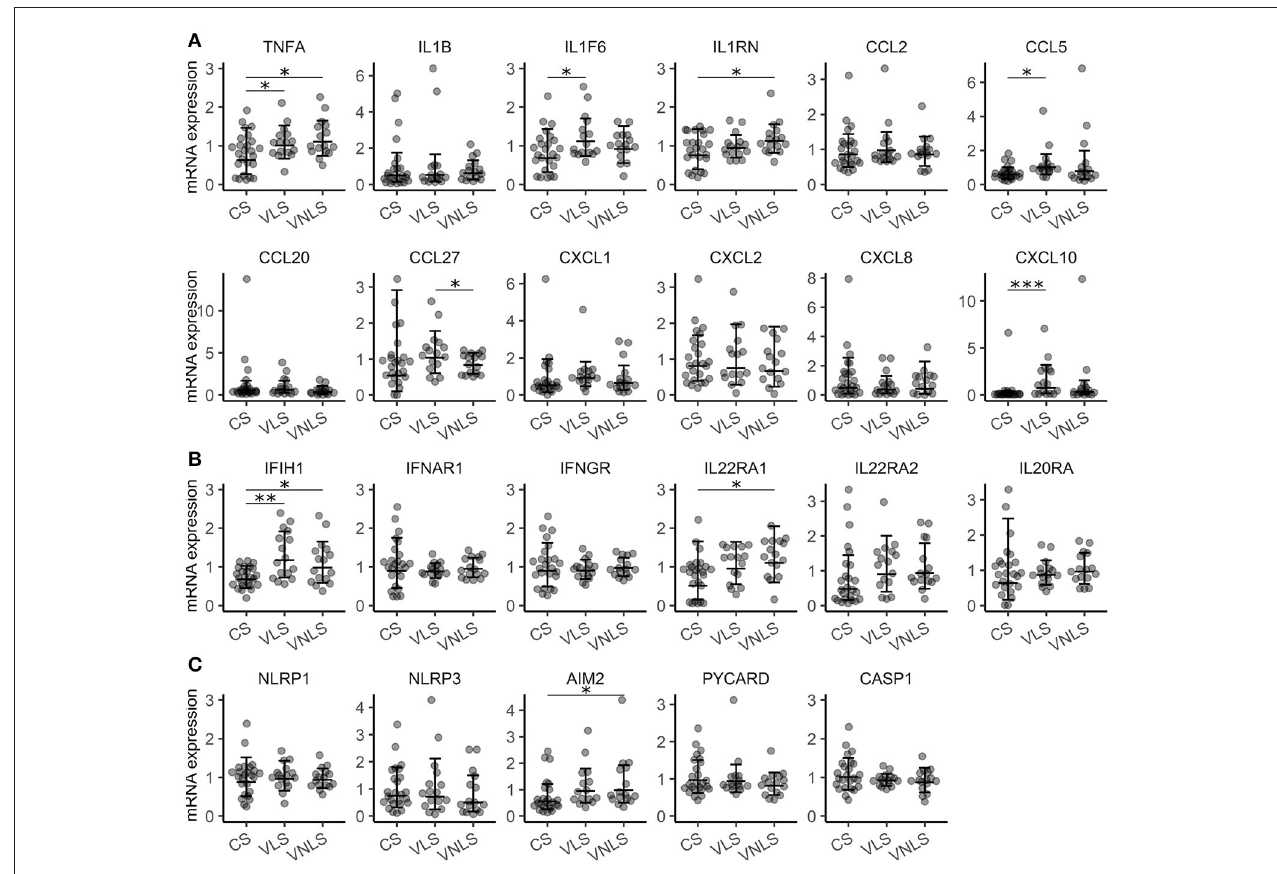
FIGURE 1 | Gene expression signature is consistent with a very mild inflammatory response in vitiligo. Relative expression of mRNAs encoding (A) cytokines, (B) receptors and (C) components of the inflammasome in the skin of control subjects (CS), and in the lesional skin (VLS) and non-lesional skin (VNLS) of vitiligo patients. Geometric mean ×÷ geometric standard deviation is indicated. * p < 0.05; ** p < 0.01; and *** p < 0.001.